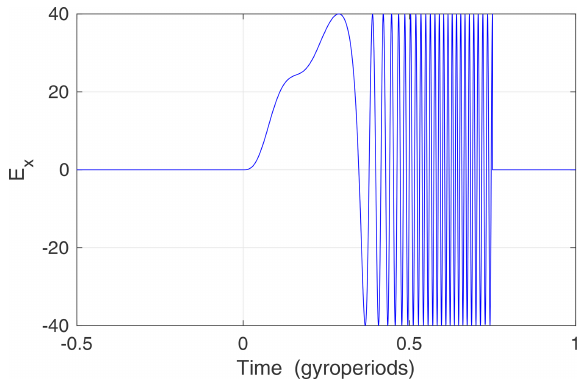
Figure 7. The normalised wave electric field E x = χ w sin (cid:56) seen by the proton from Fig. 6. Acceleration occurs only during coher- ence time 0–0.3 f − 1 cp by means of v x E x > 0. The energy gain is transferred to v y by the Lorentz force ˙ v y = − (q/m)v x B z